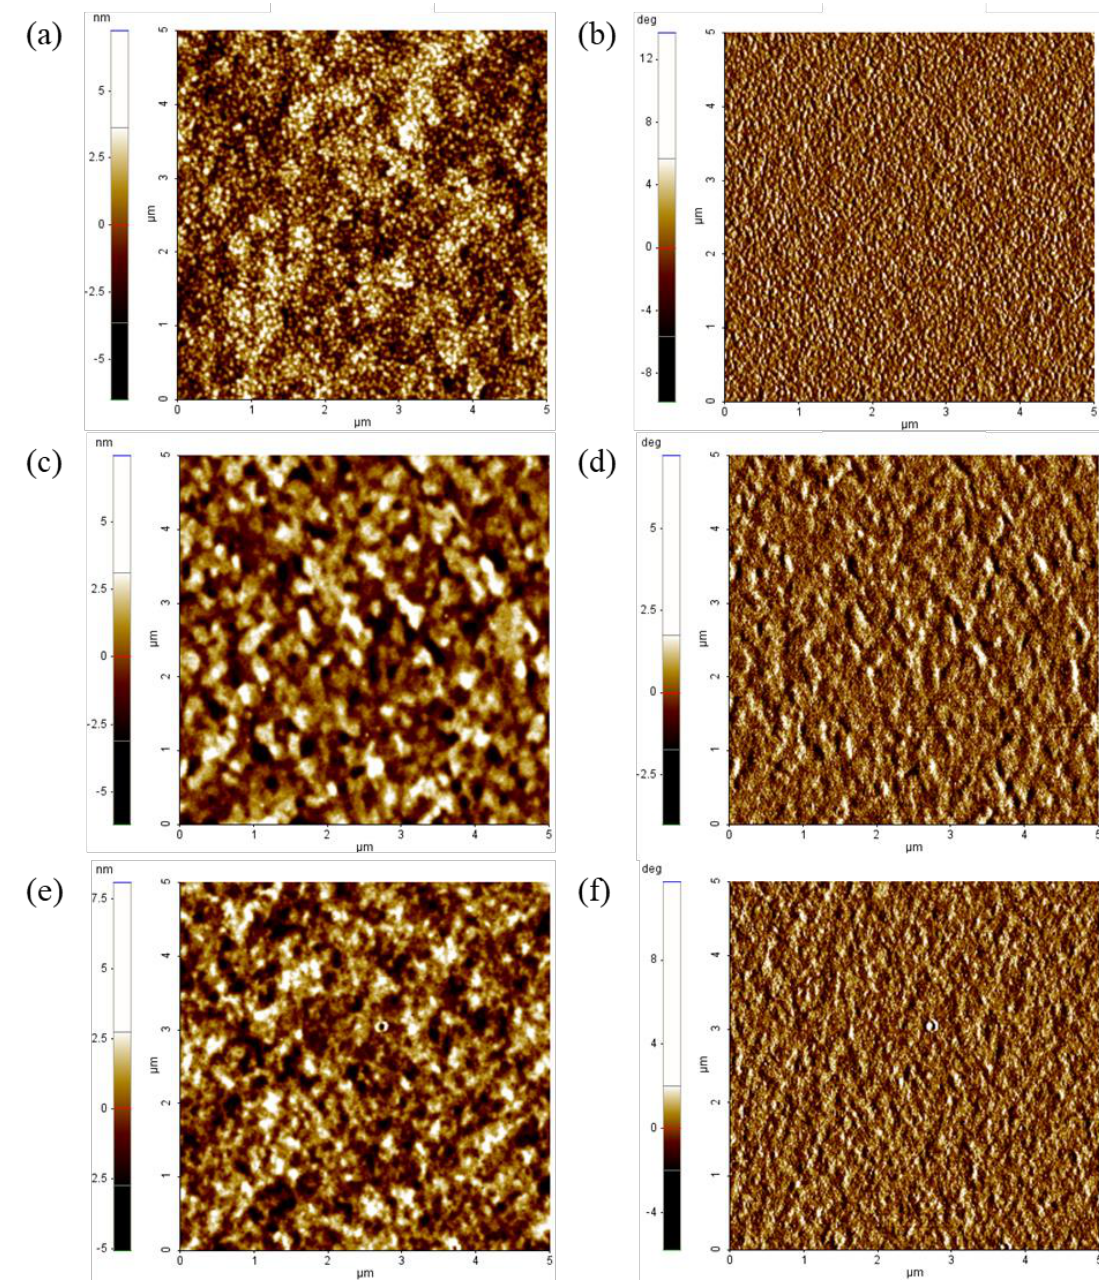
Figure 5. Atomic force microscopy (AFM) topographic and phase images of BHJ films ( a , b ) PAFDQ:PC 71 BM (R RMS = 1.77 nm), ( c , d ) PAFDQ:ITIC (R RMS = 1.51 nm), ( e , f ) PAFDQ: Y6-BO-4Cl (R RMS = 1.34 nm).